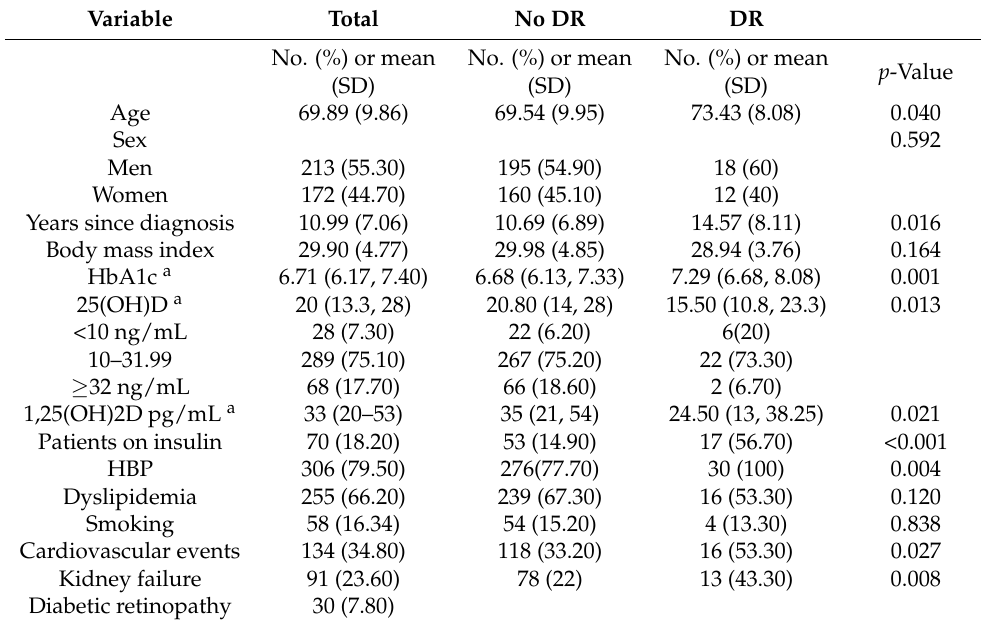
Table 1. Clinical and epidemiological